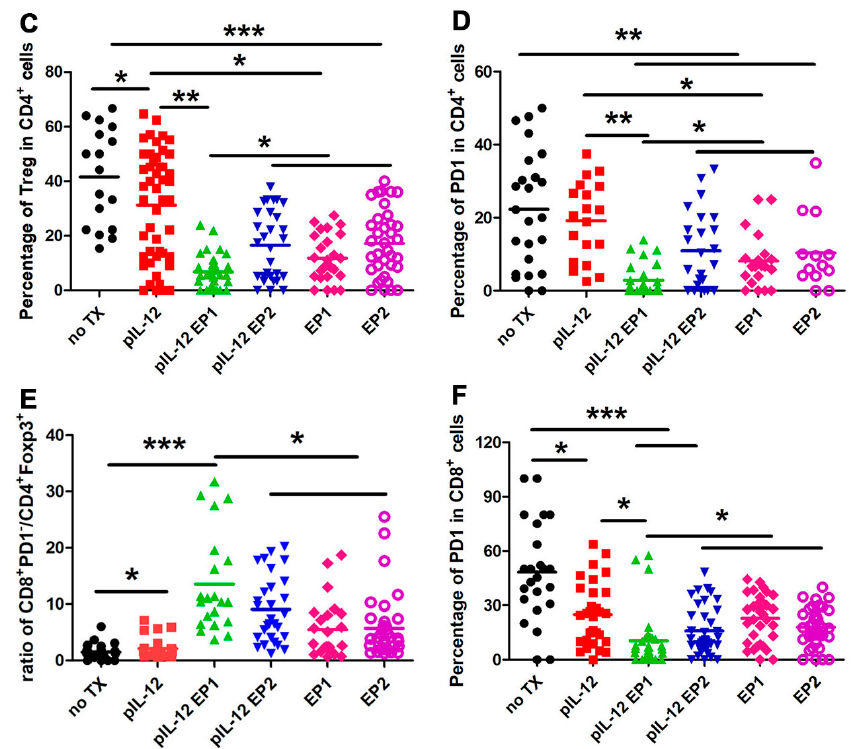
Figure 4. Changes in the Tumor Microenvironment following pmIL-12 GET. Tumors were collected at day 9 for histological analysis. ( A ) Paraffin sections of tumor tissue were stained with anti-CD4, anti-Foxp3 and anti-PD1. ( B ) Paraffin sections of tumor tissue were stained with anti-CD4, anti-Foxp3 and anti-PD1. Visualized by optical microscope (×200). ( C , D ) IHC data represented as the mean percentage of Treg cells in CD4 + and exhausted CD4 + PD1 + cells in CD4 + cells in four different groups. ( E , F ) The ratio of CD8 + T cells to CD4 + Foxp3 + Treg cells. The data presented are representative of two independent experiments. Each value represents the mean +/ − SEM of the group. The percentage of TIL was quantified in 10–20 random fields (number of total cells > 200). Horizontal bars indicate mean values. One-way ANOVA, p * < 0.05, p ** < 0.01, p ***< 0.001. In mice, CD4 + and CD8 + T cells can be further categorized into memory and naïve phenotypes based on CD44 and CD62L expression with the CD44 − CD62L − population considered naïve T cells (T N ), CD44 + CD62L + population considered central memory T cells (T CM ), CD44 + CD62L − population considered effector memory T cells (T EM ) and CD44 − CD62L − (T E ) population considered effector T